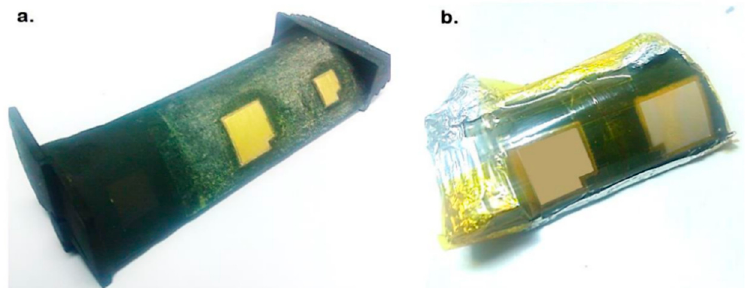
Figure 3 . Deposition of the composite piezoelectric films on the curved surface of superalloy